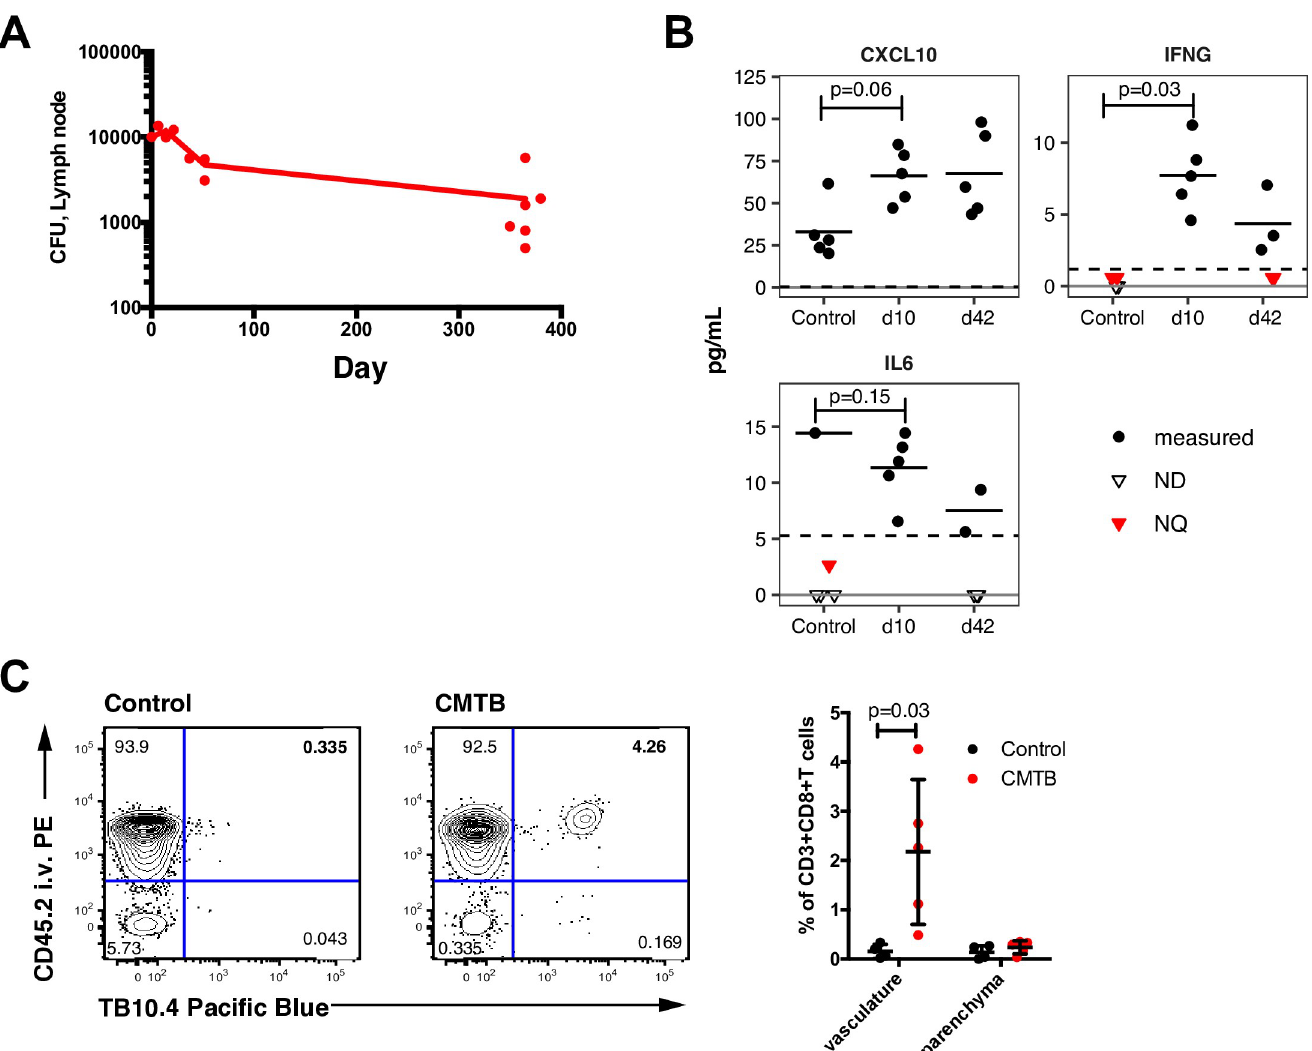
Fig 1. CMTB mice have an altered inflammatory milieu. ( A ) Mice were inoculated intradermally in the ear with 10,000 CFU of H37Rv Mtb and bacterial burden in the superficial cervical lymph nodes measured 10, 42, and 365 days following infection by CFU assay. Data are a representative experiment of 2 independent experiments with 3–6 mice/timepoint. ( B ) CMTB was established as described in ( A ) and the levels of the indicated cytokines in peripheral blood were measured by multiplexed immunoassay (Luminex) at the indicated time points. ND = below detection limit; NQ = below quantification limit. Dashed line indicates